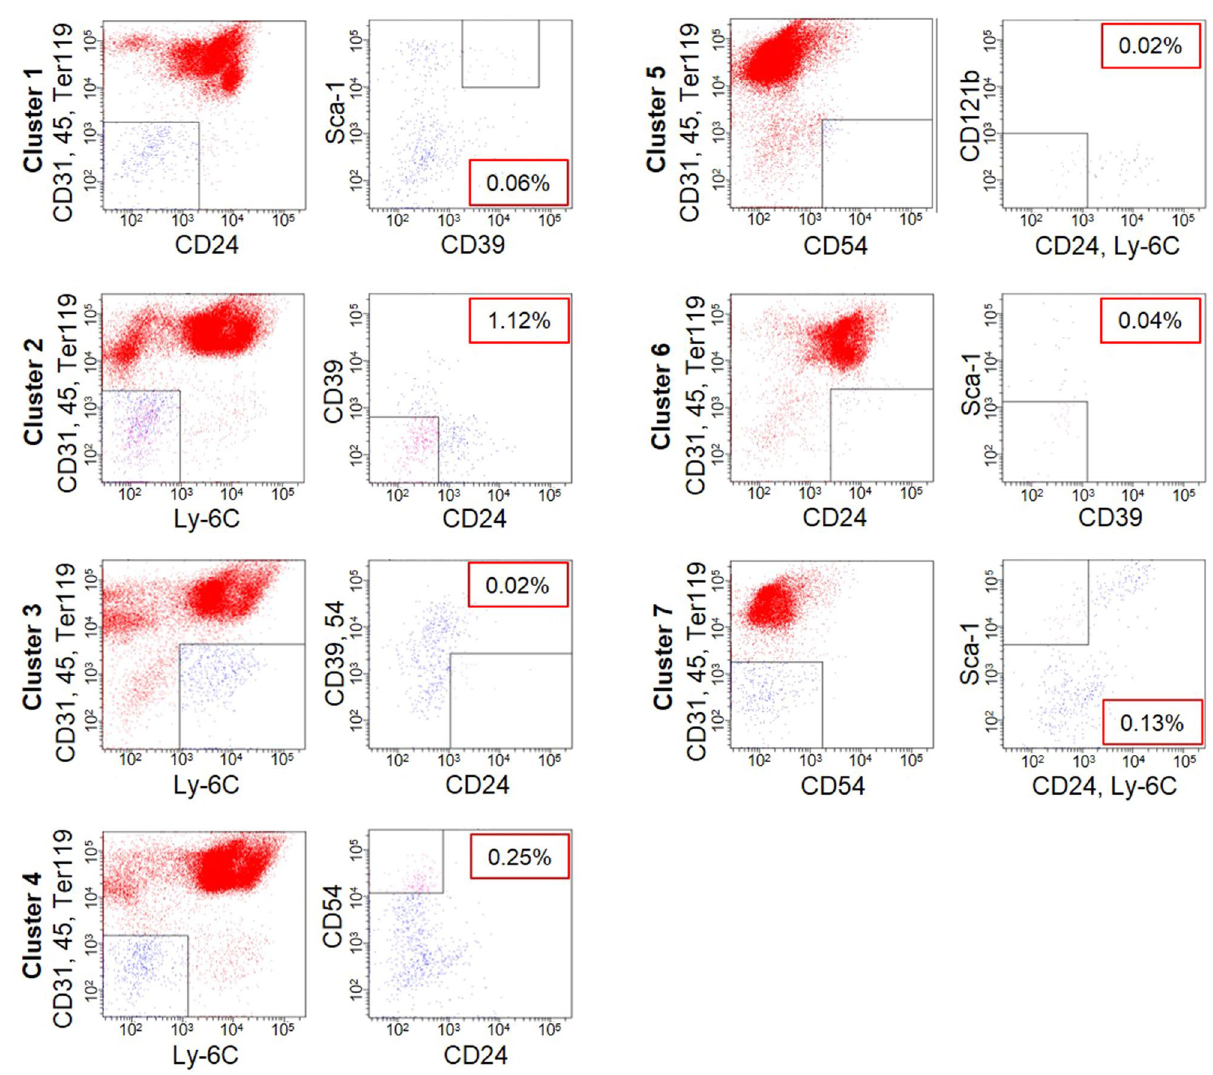
Figure 3. Isolation of each cluster using specific markers. Each cluster was isolated by using the surface antigen gene with large alteration in gene expression profiling by scRNA-seq of